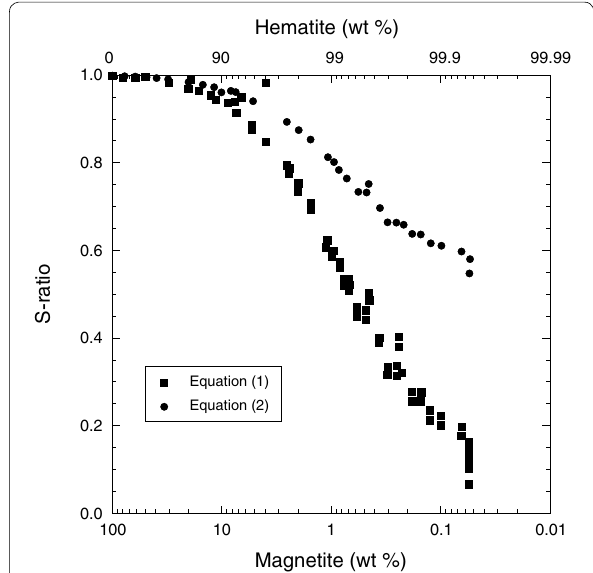
Fig. 2 S ‑ratio variations for known mixing percentages of hematite (upper axis) and magnetite (lower axis). Values are compared for two versions of the S ‑ratio expressed in Eqs. (1) and (2) with a 300‑mT cut‑off field. The large magnetic property difference between magnetite and hematite means that the S ‑ratio is highly non‑linear with respect to hematite content (Redrawn from Frank and Nowaczyk